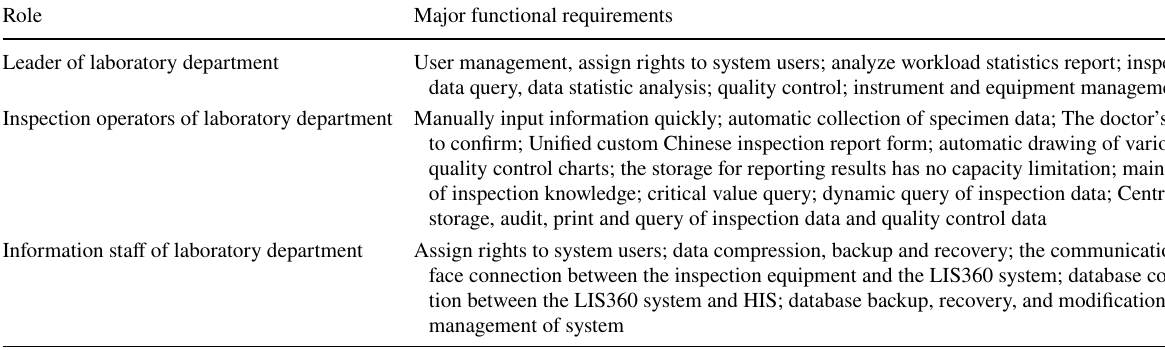
Table 1 Description of user functional requirements Role